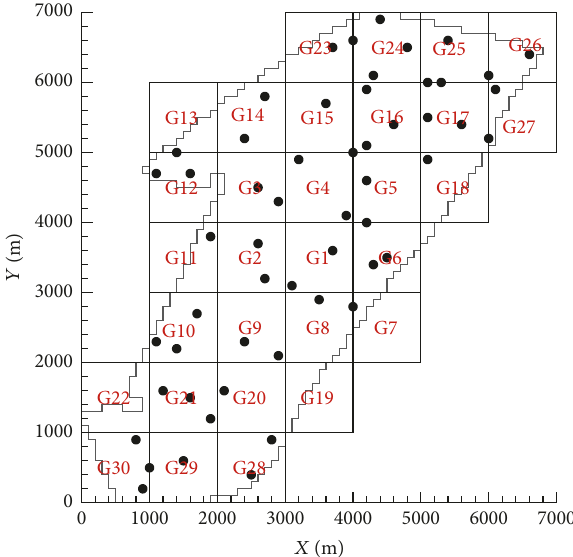
Figure 3: Reference 𝛼 field. Locations of the 55 observation wells (black circles). Figure 4: Grid numbers and locations of the observation wells used for the inverse